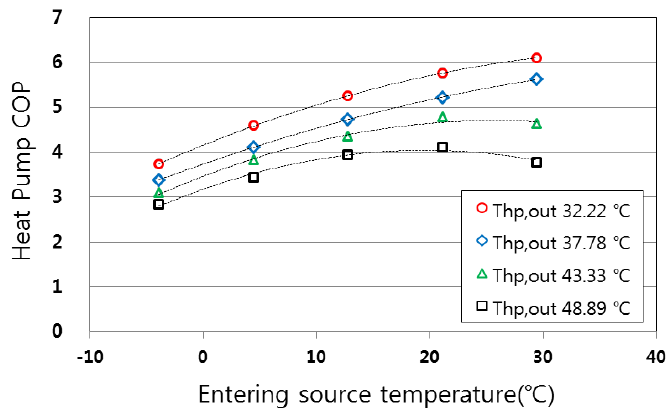
Figure 3. Performance curve of the heat pump.